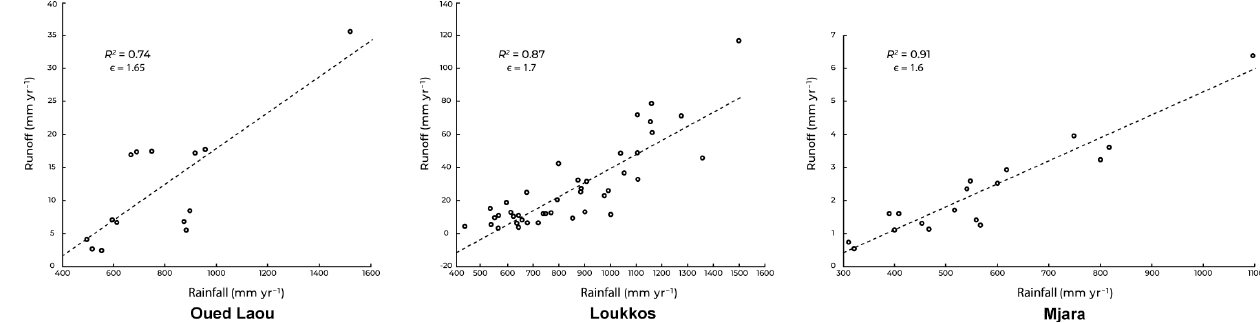
Figure 9. Elasticity coefficient estimation for the three watersheds using a regression